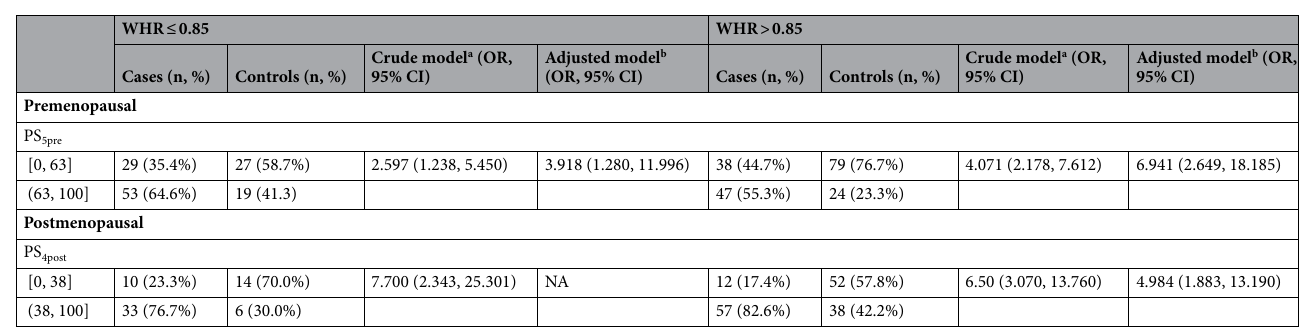
Figure 6. The association between PS 4post and the risk of postmenopausal breast cancer risk of different molecular subtypes. *lb the lower limit of confidence interval, ub the upper limit of confidence interval, ler the distance from OR to the lower limit of confidence interval, uer the distance from OR to the upper limit of confidence interval, ref OR = 1. The figures were conducted using R 3.5.1 software (R Core Team, Vienna, Austria, 2018. https:// www.R- proje ct. org/) and Microsoft EXCEL software (Microsoft, USA, 2016. https:// www. micro soft. com/ zh- cn/ micro soft- 365/ excel).